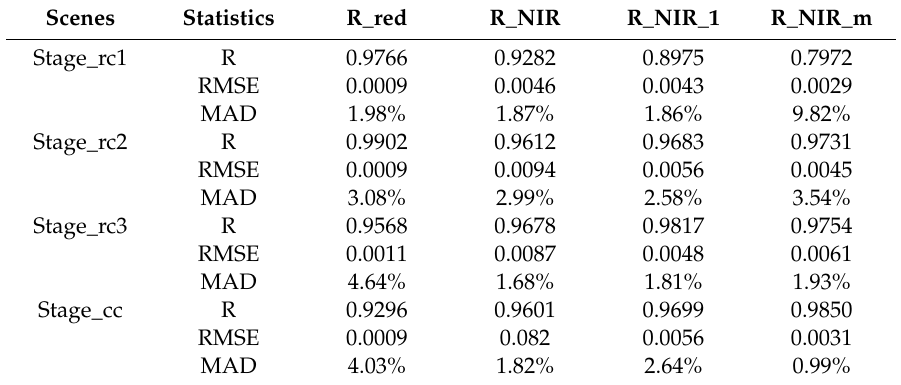
Table 4. The statistical results of the comparison of curves of reflectance simulated by the row model versus the reflectance simulated by the Radiosity–Graphics Combined Model (RGM)